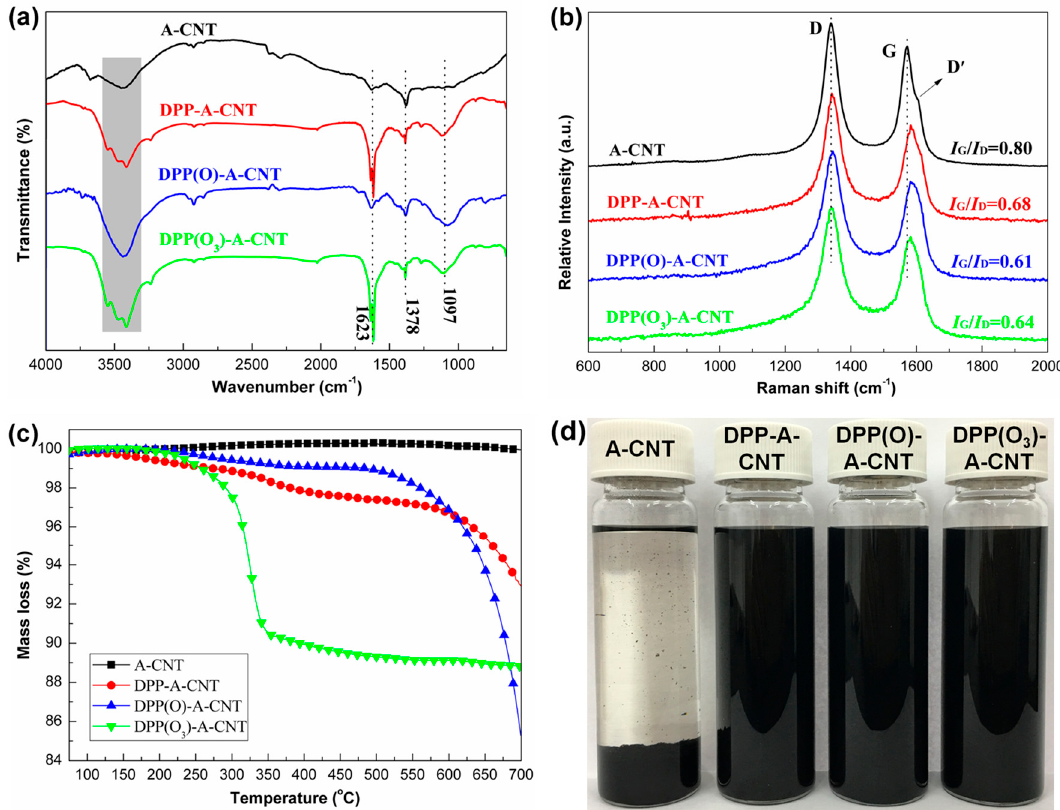
Figure 2. Characterizations of A-CNT, DPP-A-CNT, DPP(O)-A-CNT and DPP(O 3 )-A-CNT: ( a ) FTIR spectra; ( b ) Raman spectra; ( c ) thermogravimetric curves; and ( d ) the dispersion of functionalized CNTs in DMF after one week.